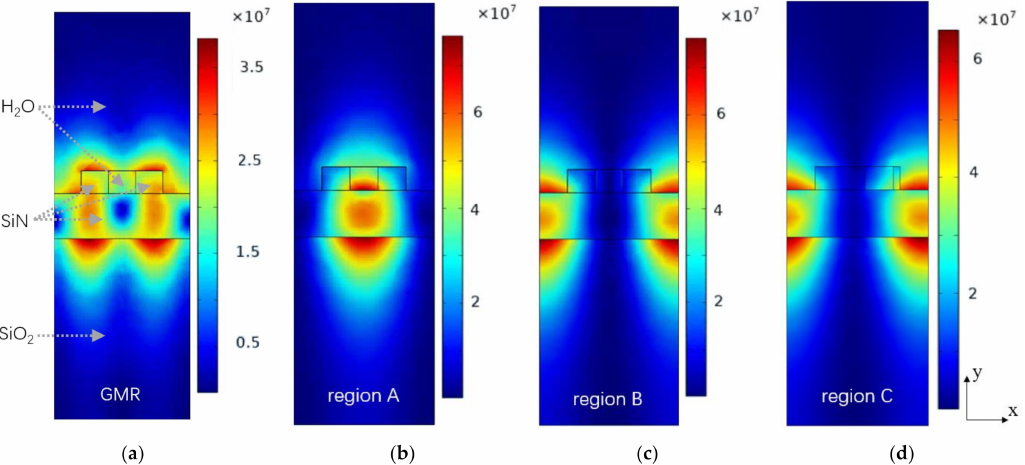
Figure 6. ( a – c ) Normalized electric field distribution of the GMR and the BIC in region A and B when the asymmetry parameter is 0. ( d ) Normalized electric field distribution in region C when the asymmetry parameter is 0.52, and the square of H 2 O moves to the side of gratings thereby. The color represents the intensity of electric field.